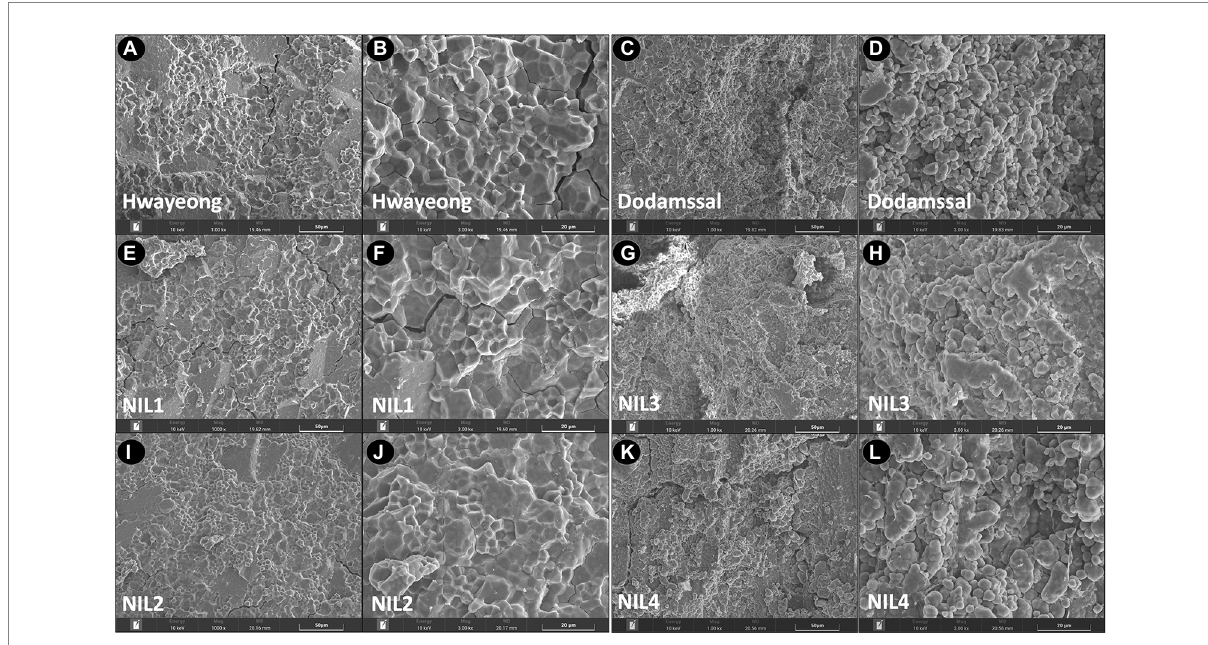
FIGURE 2 Ultrastructure of endosperm surface structure observed by scanning electron microscope in two parental lines and four NILs. Hwayeong (A,B) , Dodamssal (C,D) , NIL 1 (E,F) , NIL 2 (I,J) , NIL 3 (G,H) , and NIL 4 (K,L) with two different magnifications (x 1,000 and x